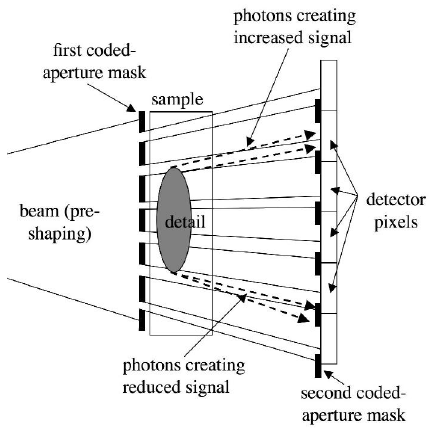
Figure 5. Schematization of the coded-aperture XPCi